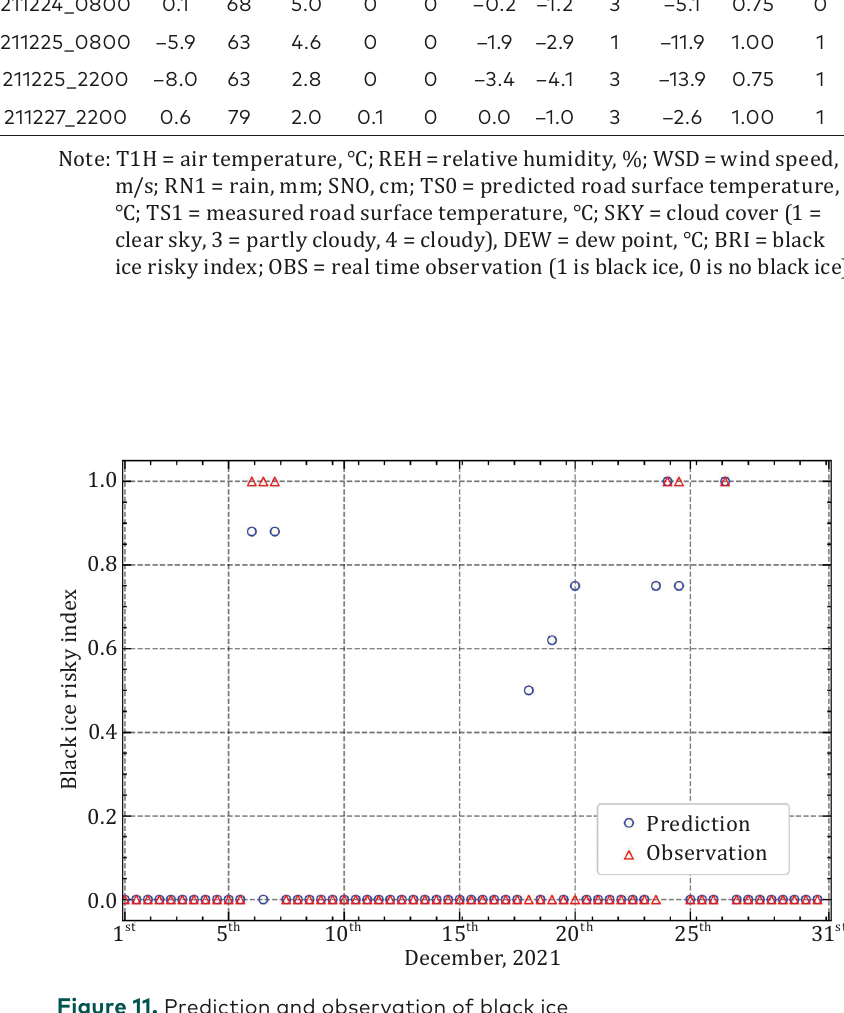
Figure 11. Prediction and observation of black ice December,